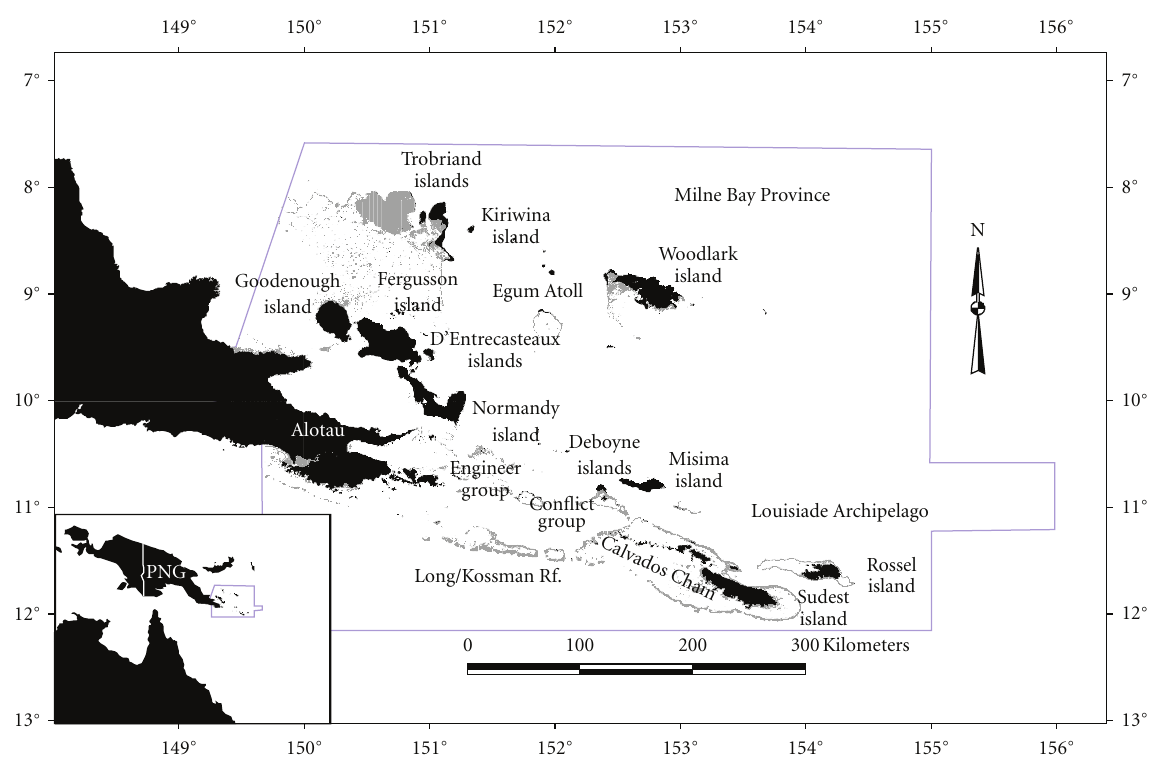
Figure 2: Map showing Milne Bay Province. Black areas represent dry land, and grey areas coral reefs and coastal habitats.